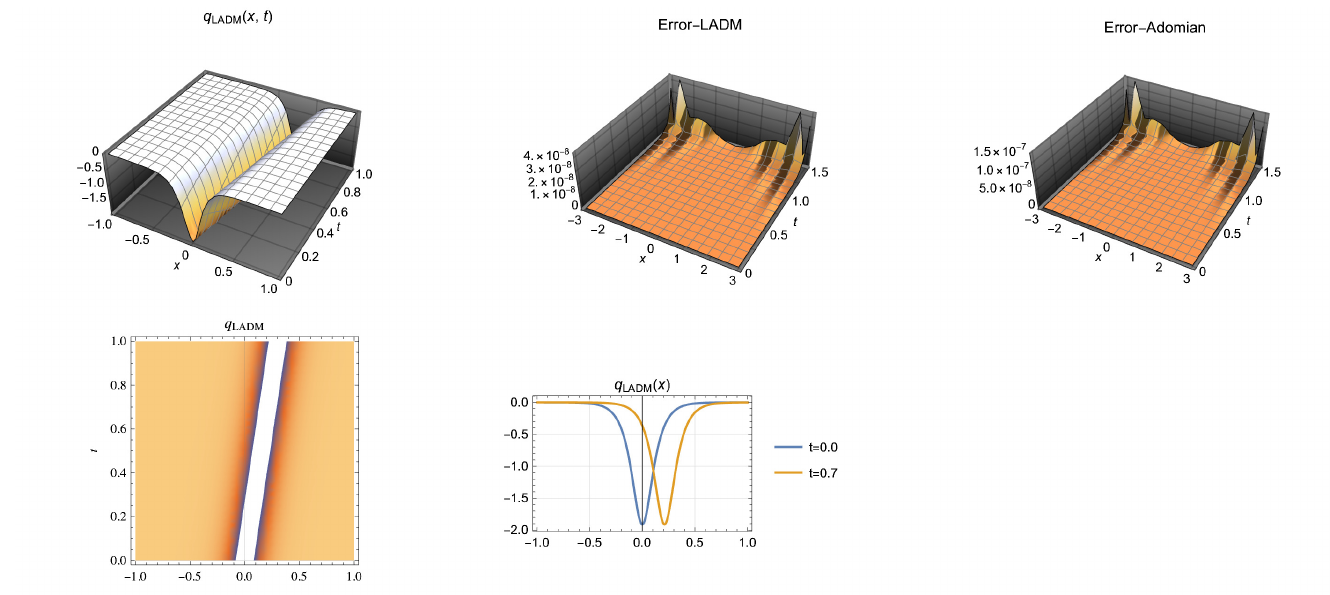
Figure 4. Soliton profile q LADM ( x , t ) in the interval − 1.0 ≤ x ≤ 1.0, for the parameters selected in Case 4 ( above left ). Error by LADM ( above center ) and error by Adomian method ( above right )). Density graph ( bottom left ). Two dimensional (2D) graph for t = 0.0 and t = 0.7 ( bottom right